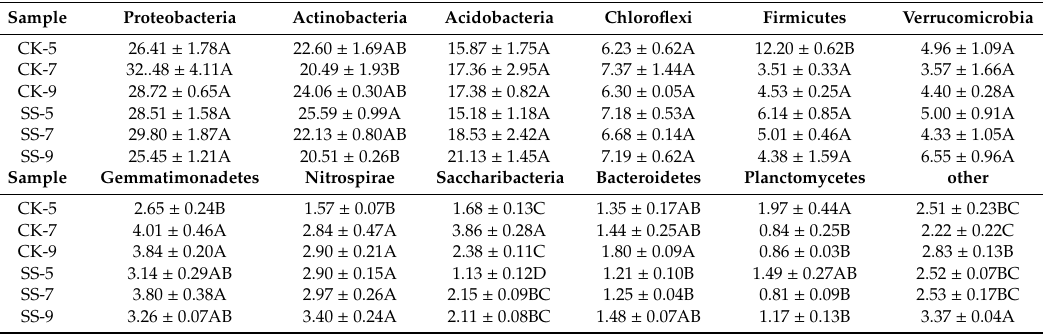
Table 3. Relative abundance (%) of bacterial phyla among CK-5, CK-7, CK-9, SS-5, SS-7, SS-9 samples based on total sequence reads. CK: Control, soil of non-infected P. sylvestris var. mongolica ; SS: treatment, soil of infected P. sylvestris var. mongolica ; May, July, and September represent spring, summer, and autumn, respectively. Di ff erent letters indicate a significant di ff erence at p < 0.05 according to Duncan’s new multiple range test.